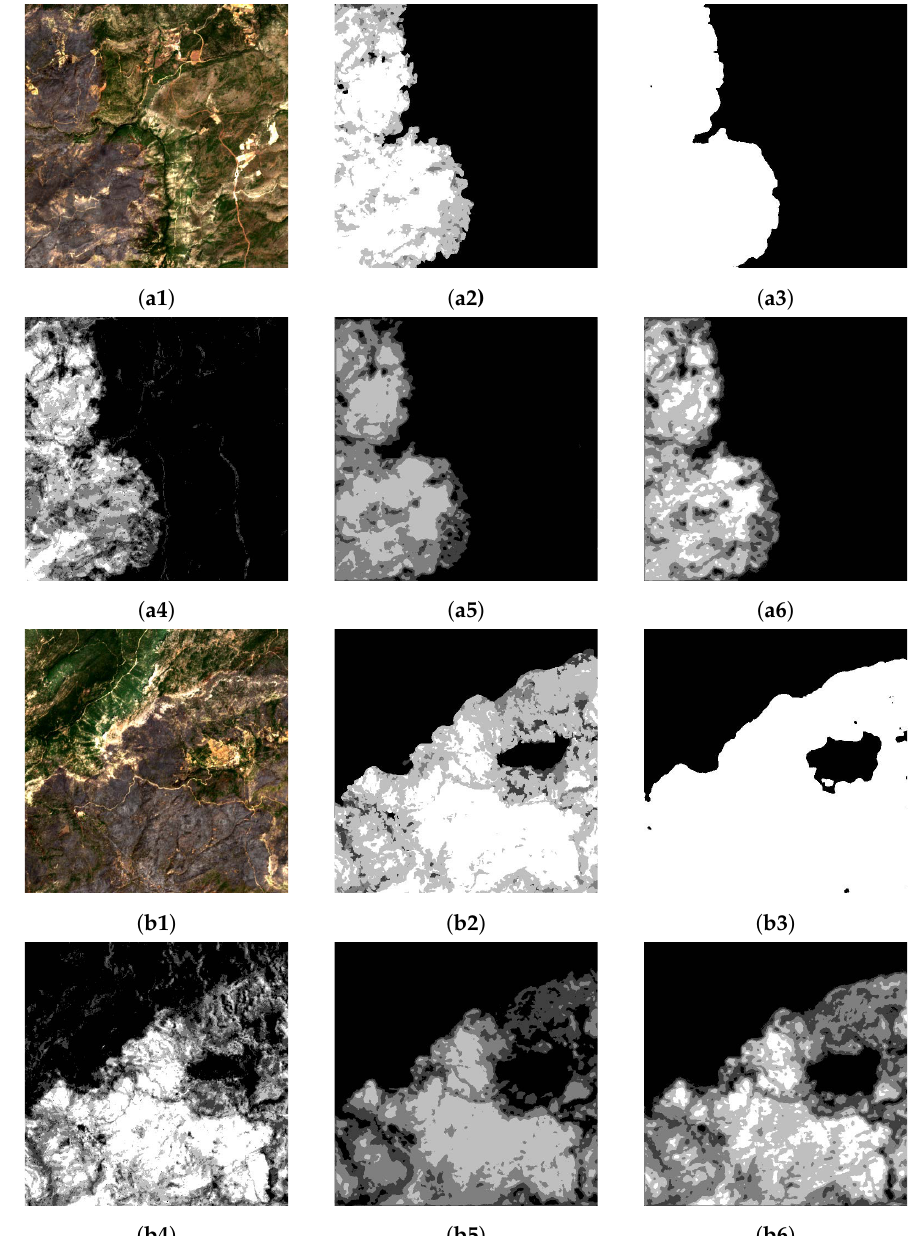
Figure 6. Wildfire severity level predictions. The severity levels range from black (severity 0) to white (severity 4). ( a1 , b1 ) Sentinel L2A acquisition; ( a2 , b2 ) Copernicus EMS grading map (GT); ( a3 , b3 ) Binary mask generated by the Binary U-Net: black and white colors indicate unburned and burned regions, respectively; ( a4 , b4 ) Thresholded dNBR, obtained from pre and post-fire acquisitions; ( a5 , b5 ) Single U-Net prediction; ( a6 , b6 ) Double-Step U-Net